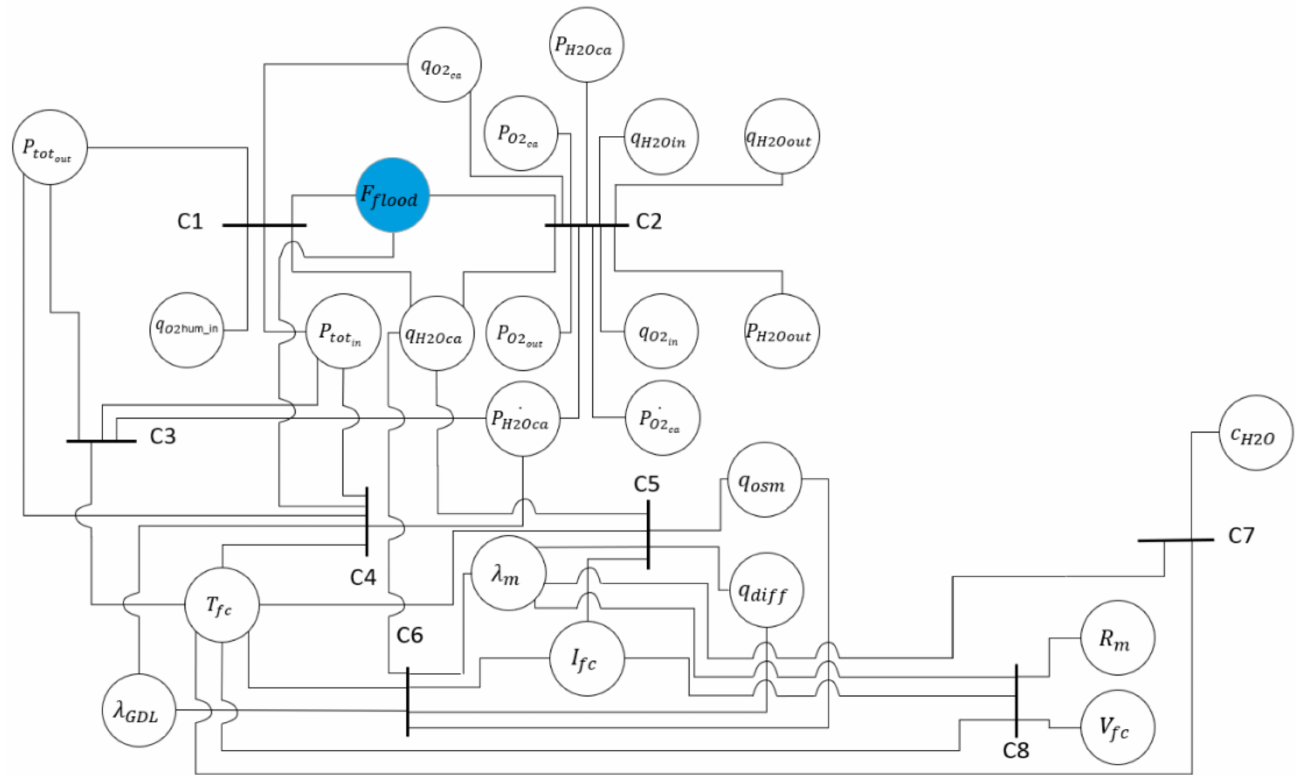
Figure 7. Structural graph with the flooding